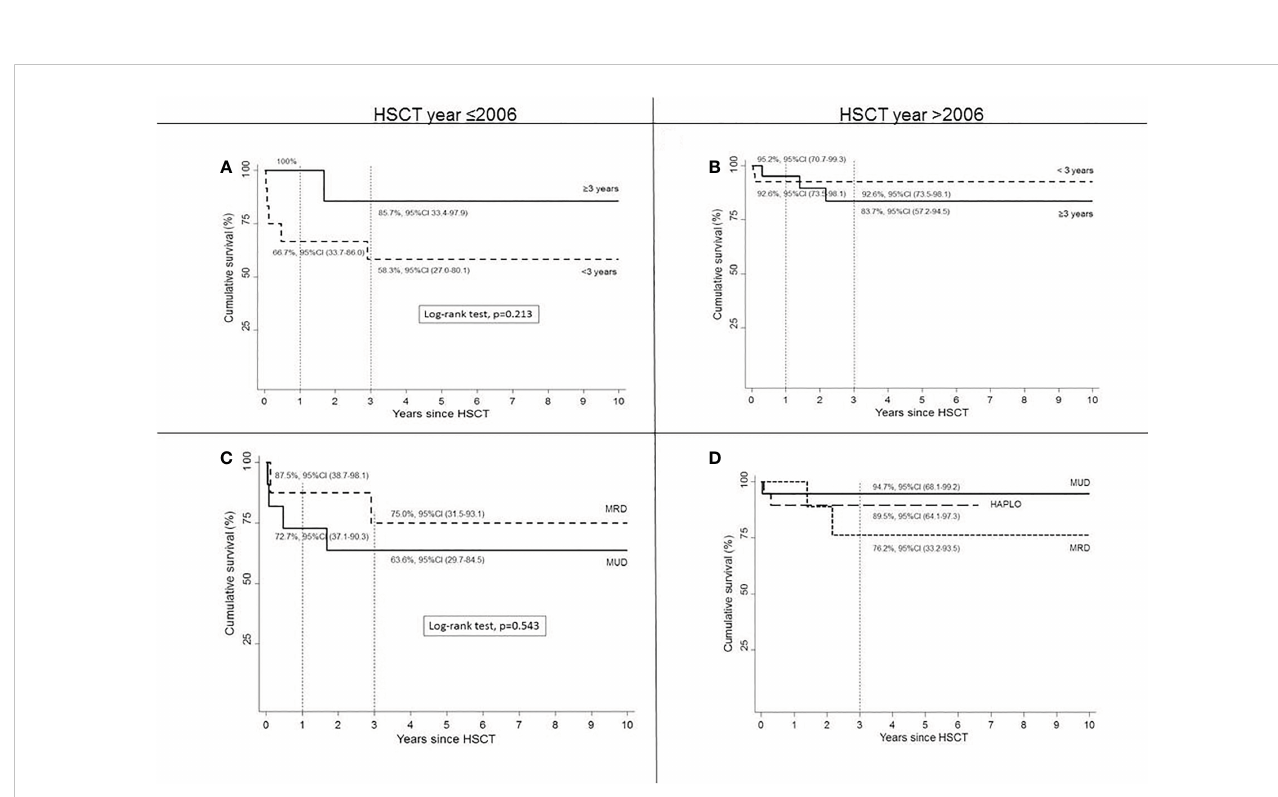
FIGURE 3 Survival according to age at HSCT by year ≤ 2006 (A) or >2006 (B) and according to type of donor by HSCT year ≤ 2006 (C) or >2006 (D)